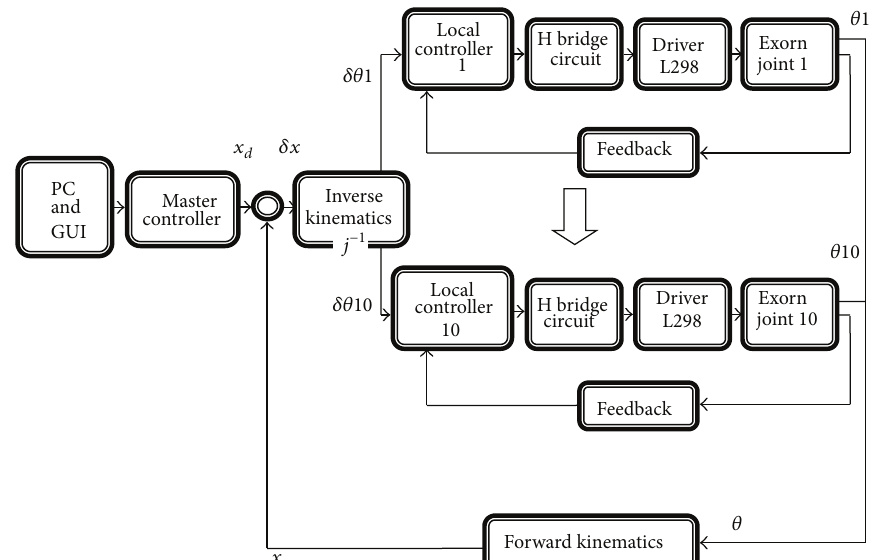
Figure 21: Independent joint control system.